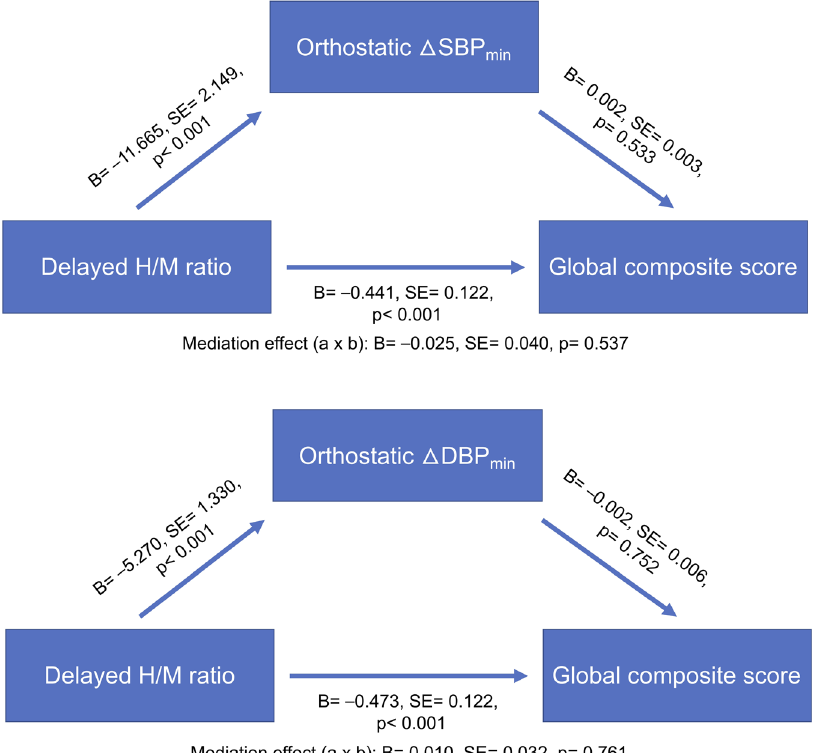
Fig. 1 Path diagram of mediation analysis for global composite score. H/M heart-to-mediastinum, SBP systolic blood pressure, DBP diastolic blood pressure, B estimate, SE standard